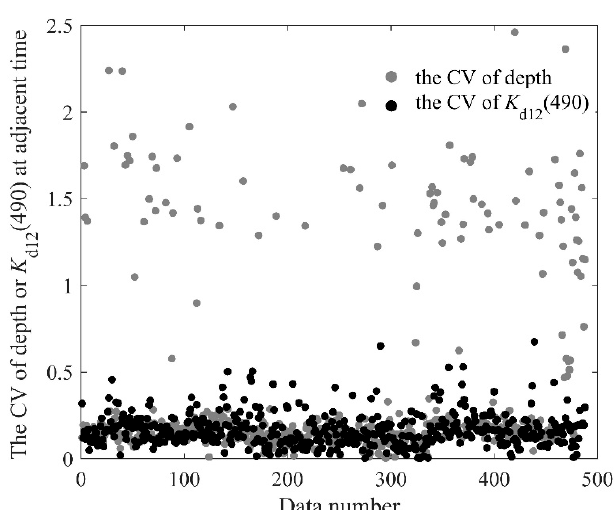
Figure 3. The coefficients of variation of depth and K d ( 490 ) at the adjacent time of data acquisition (redrawn from Zhang et al. [37]).